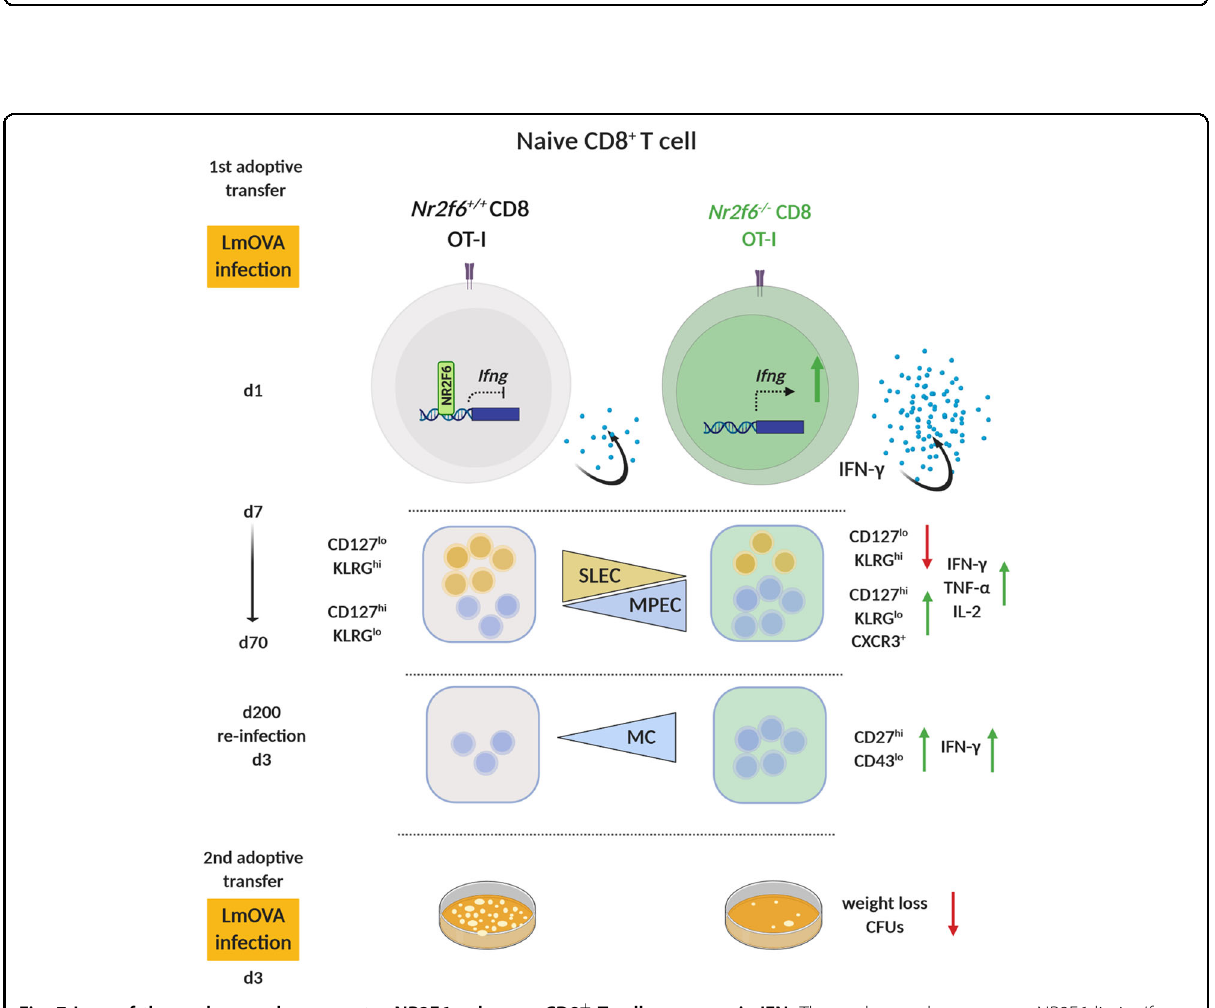
Fig. 7 Loss of the orphan nuclear receptor NR2F6 enhances CD8 + T-cell memory via IFN. The nuclear orphan receptor NR2F6 limits Ifng transcription in the early phase of an anti-bacterial CD8 + T cell response (d1). Within an OT-I adoptive cell transfer model, intrinsic-loss of NR2F6 in CD8 + T cells augments IFN- γ secretion, which enhances the proportion of memory-precursor effector cells (MPECs CD127 hi KLRG1h lo ) over short-lived effector cells (SLECs CD127 lo KLRG1 hi ). Furthermore, the secretion of the pro-in fl ammatory cytokines IFN- γ , TNF- α , and IL-2 are enhanced during the acute anti-bacterial response (d7). Enhanced memory Nr2f6 − / − OT-I CD8 + T-cells persist after the contraction phase (d70) but wane long-term (>d140). Upon re-infection (>d200), Nr2f6 -de fi cient memory OT-I CD8 + T-cells raise enhanced recall responses and are – following adoptive transfer into naïve mice - superior in clearing secondary LmOVA